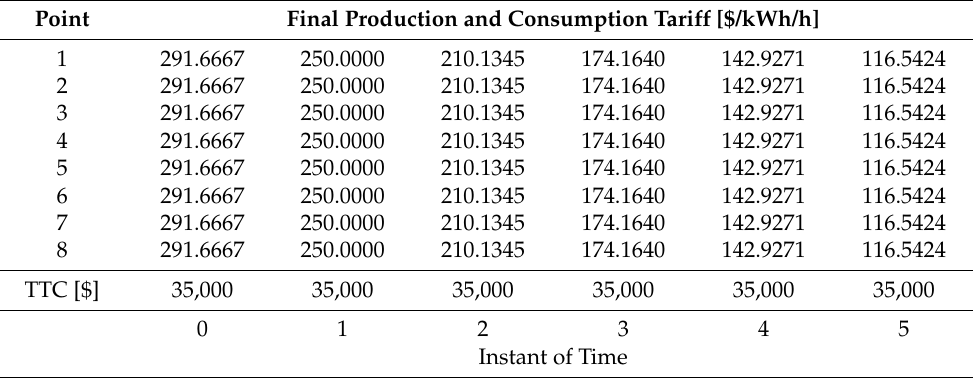
Table 4. Final production and consumption tariffs for each point and the total transportation cost between the instants of time 0 and 5 with W F = 0.